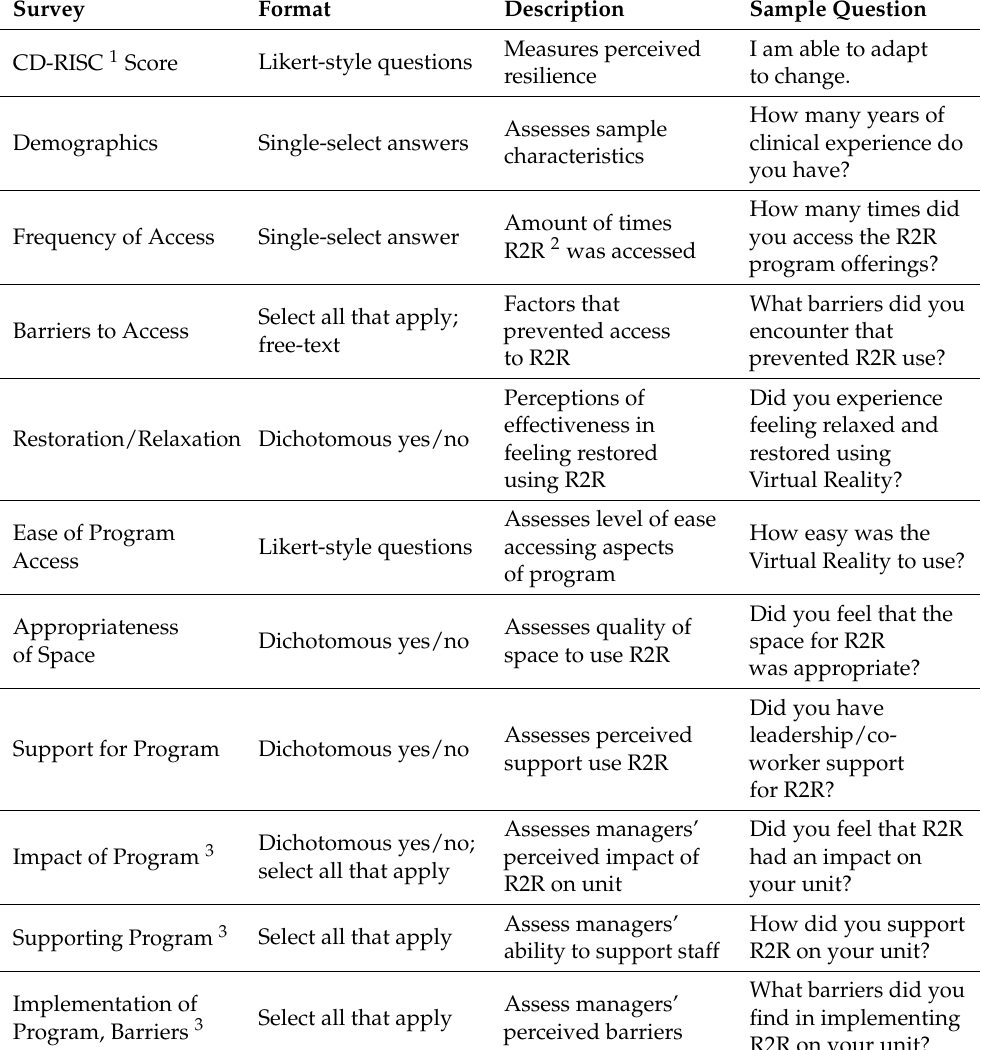
Table 3. Surveys and Sample